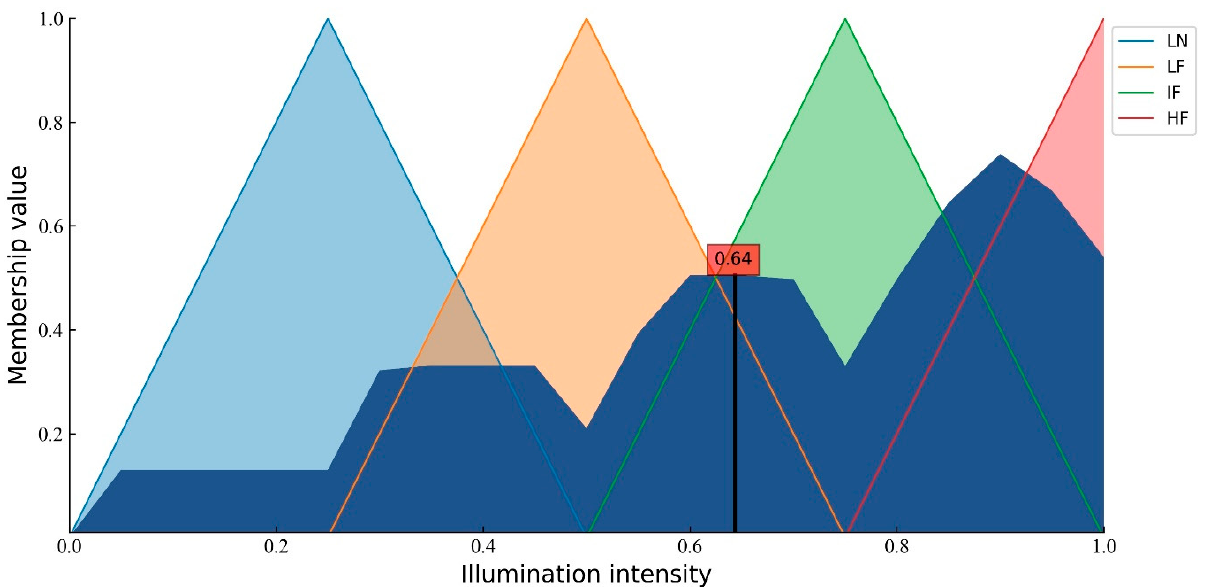
Figure 9. The aggregation rules.